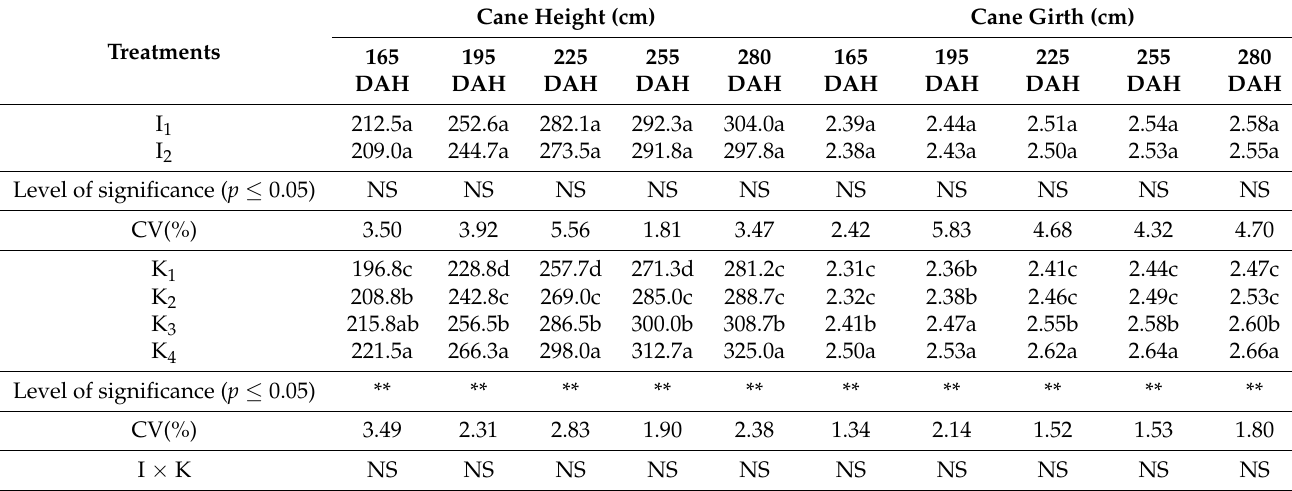
Table 1. The height and girth of sugarcane are influenced by different levels of irrigation and potassium.